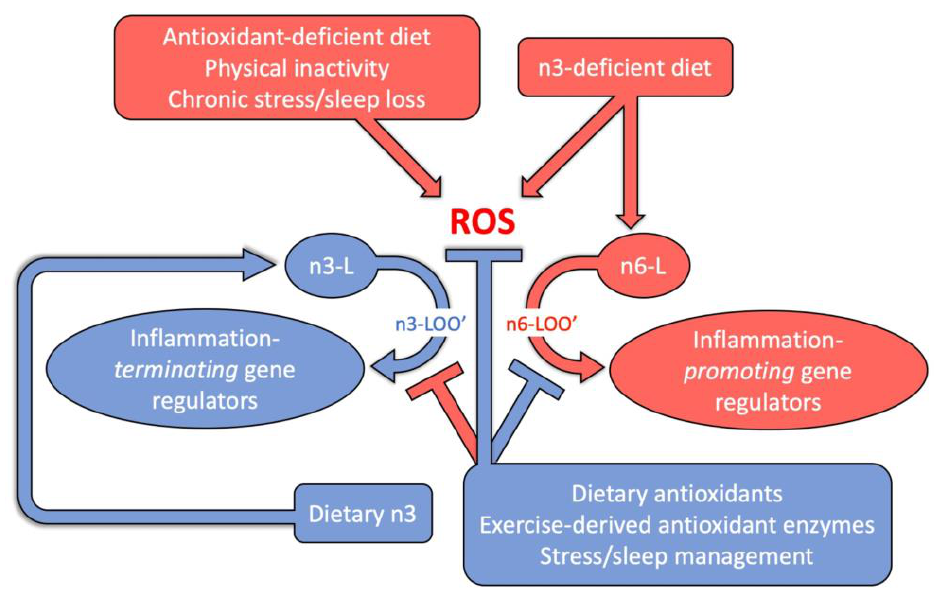
Figure 4. Schematic depiction of interactions between diet and other lifestyle factors in modulating reactive oxygen species (ROS) and regulators of the immune response derived from oxidation products of membrane phospholipids containing either omega-3 fatty acids (n3-L) or omega-6 fatty acids (n6-L). Red boxes and arrows designate inflammation-promoting factors and responses, while blue boxes and arrows designate inflammation-terminating factors or responses. Note that dietary antioxidants have the dual effect of dampening the production of inflammation-promoting n6-L-based regulators (blue T-shaped line) as well as dampening the production of inflammation- terminating n3-L-based regulators (red T-shaped line).